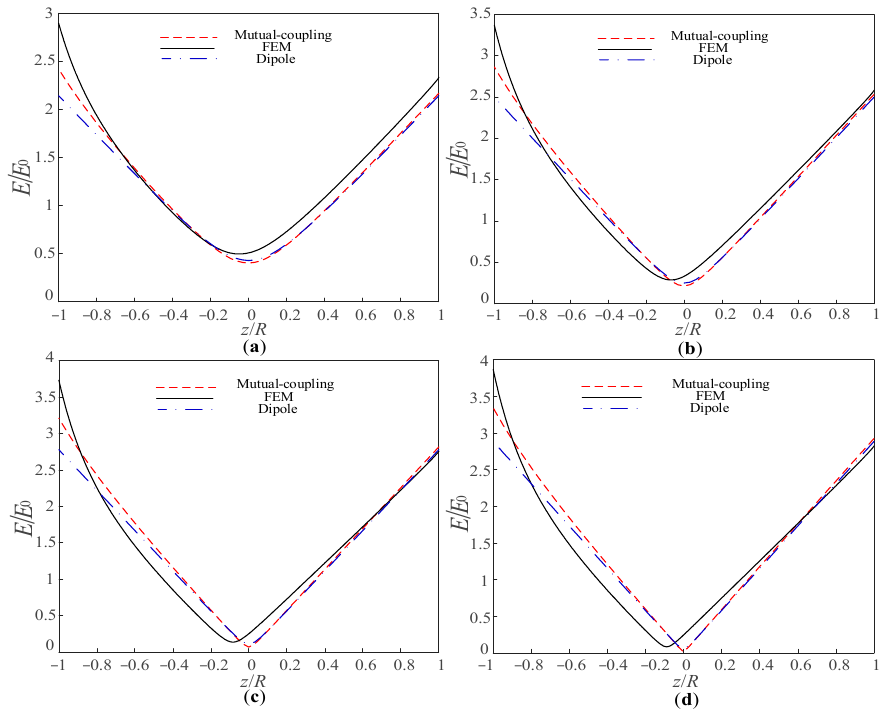
Figure 6. Calculation results of the electric field distribution on particle 1 when D / R = 0.6: ( a ) Calcu- lation results when ε i / ε e = 5; ( b ) Calculation results when ε i / ε e = 10; ( c ) Calculation results when ε i / ε e = 25; ( d ) Calculation results when ε i / ε e = 50.